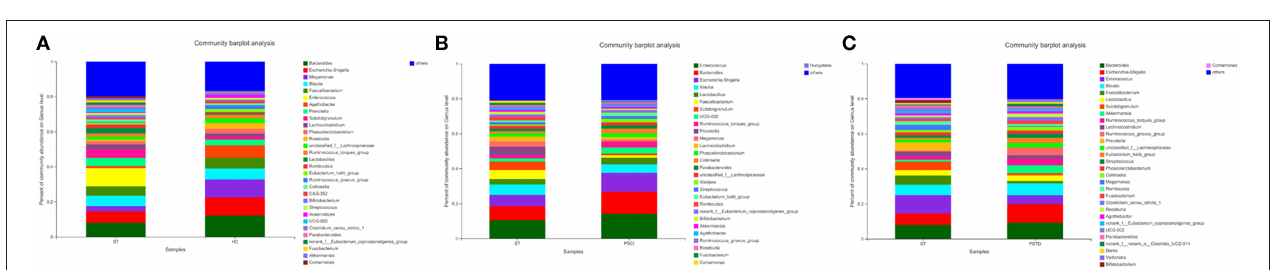
FIGURE 4 | Distribution of the predominant bacteria at genus level of different groups. (A) ST vs. HC, (B) PSCI vs. ST, (C) PSTD vs. ST. The predominant taxa (>1% relative abundance) in each level are shown.